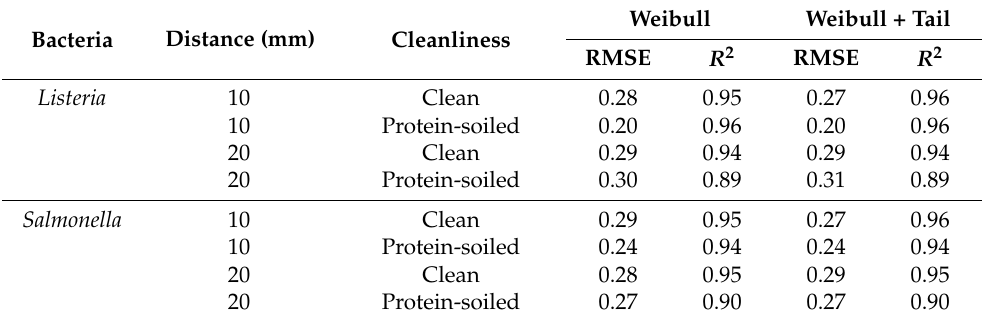
Table 2. Goodness of fit (RMSE and R 2 ) for the Weibull and Weibull + tail inactivation curves.